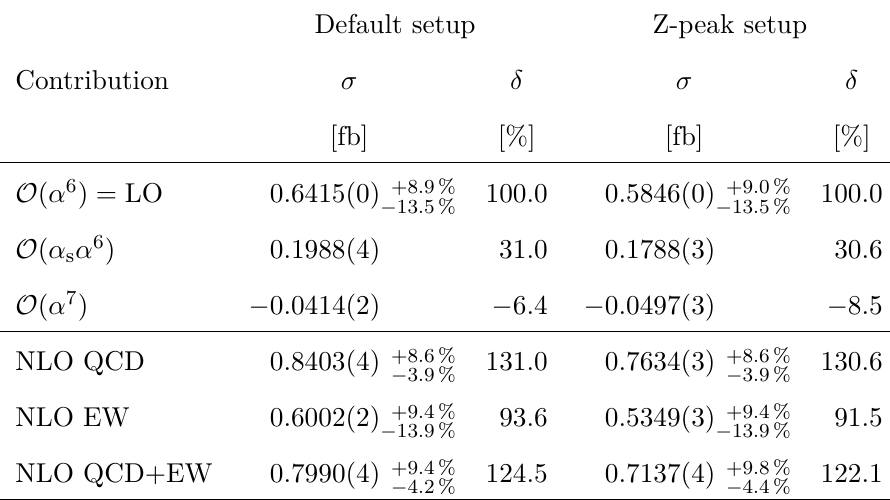
Table 1. Integrated cross sections, σ , for LO, NLO QCD, NLO EW, and NLO QCD+EW in the default setup and the Z-peak setup [with the additional cut eq. (2.19)]. Numbers in parentheses are statistical uncertainties from the Monte Carlo integration. Zero entries indicate uncertainties smaller than the given precision. Asymmetric percentages give the envelope of a 7-point scale variation. Finally, δ is the size of each contribution in terms of the